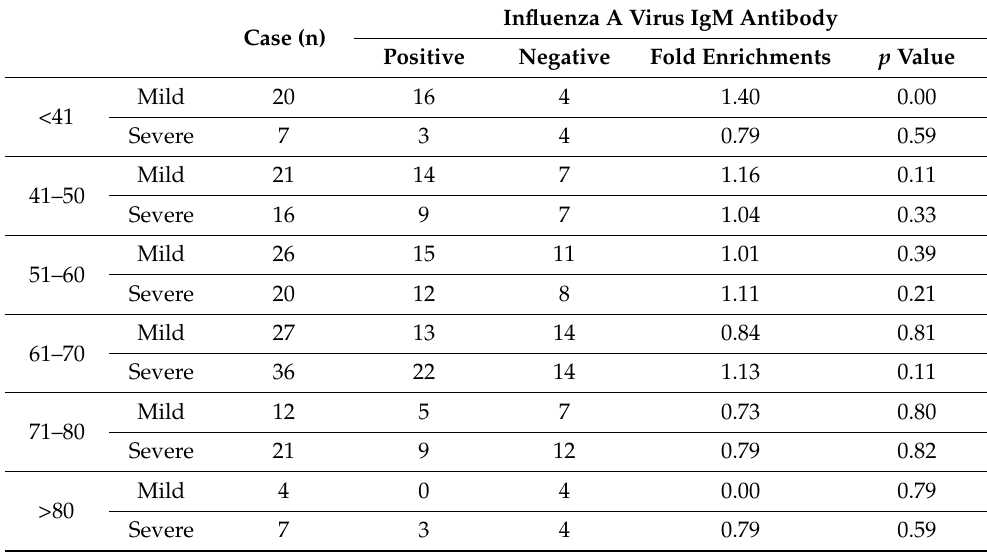
Table 6. Enrichment statistical analysis for COVID-19 patients with influenza A virus